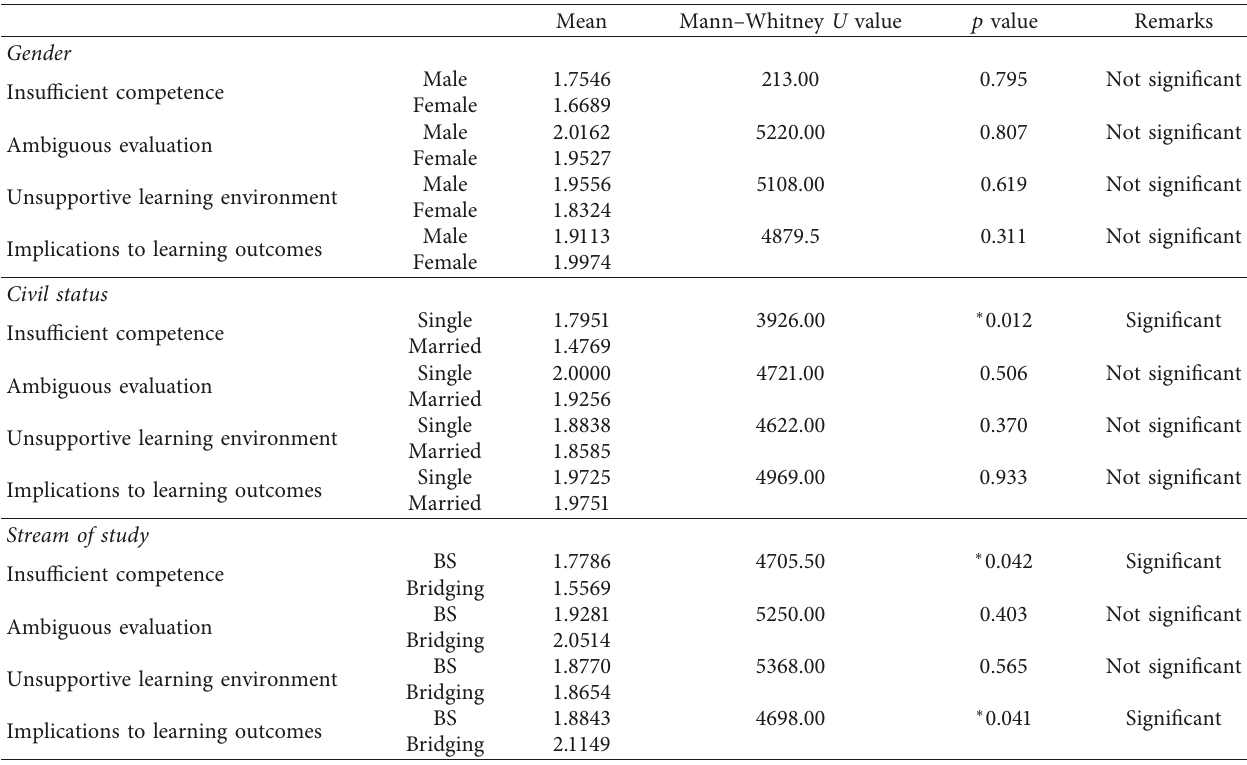
Table 5: Differences of students’ perception towards clinical challenges and implications in terms of civil status and stream of